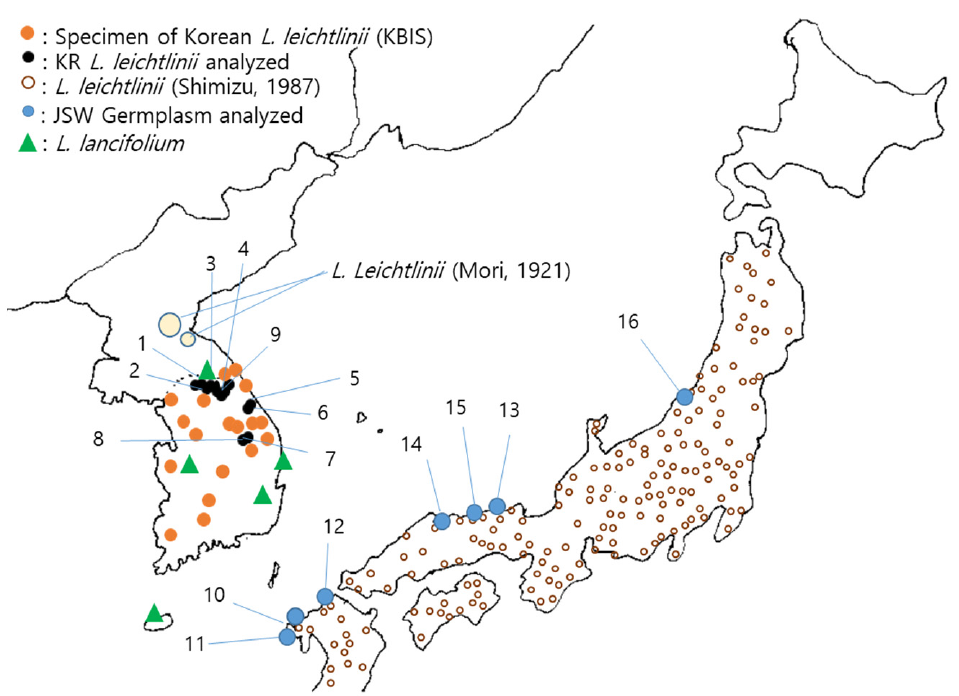
Figure 1. Distribution maps and collection sites of L. leichtlinii accessions in Korea and Japan (numbers 1–16 refer to numbers in Table 1). Distribution maps of L. leichtlinii are drawn based on the present study, reports by Mori [24] and Shimizu [12], and information on specimen distribution from KBIS [25]. Table 2. Summary of morphological characteristics of JSW and KR groups of L. leichtlinii .